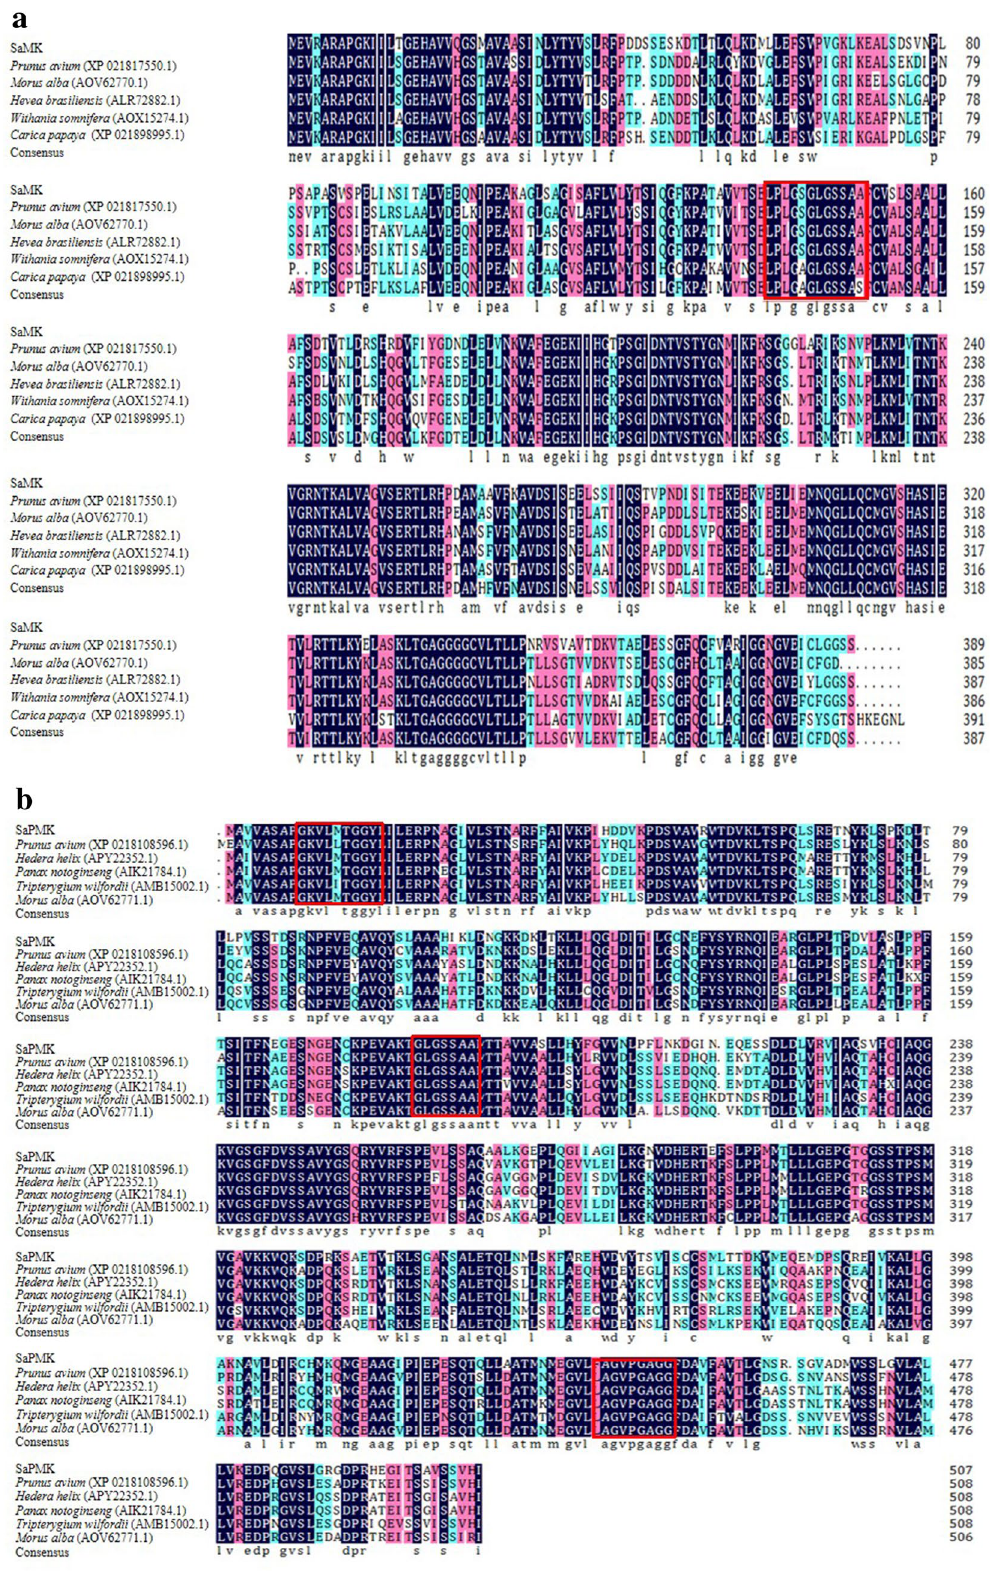
Figure 3. Multiple alignments of SaMK ( a ) and SaPMK ( b ) deduced amino acid sequences in Santalum album with other corresponding homologous proteins. Red frames indicate conserved